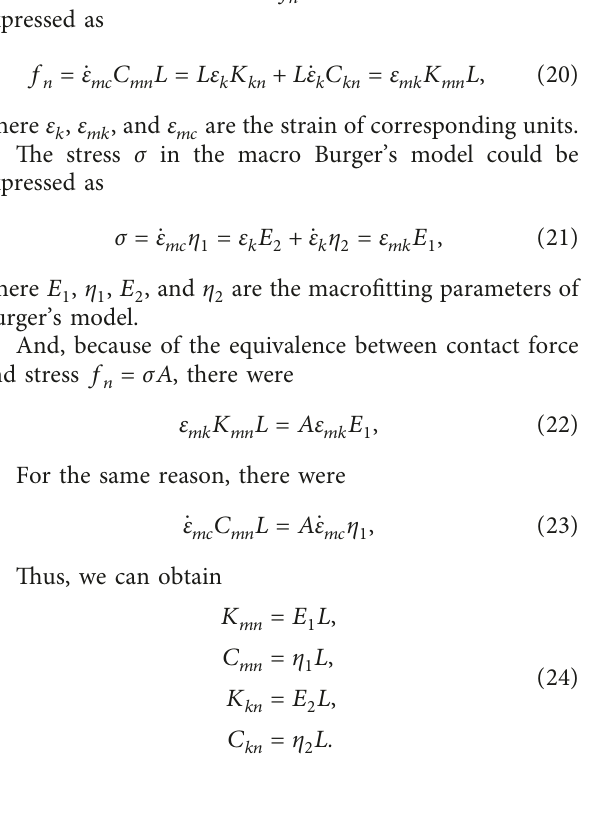
Figure 10: Burger’s model of particle contact. (a) Normal direction and (b) tangent